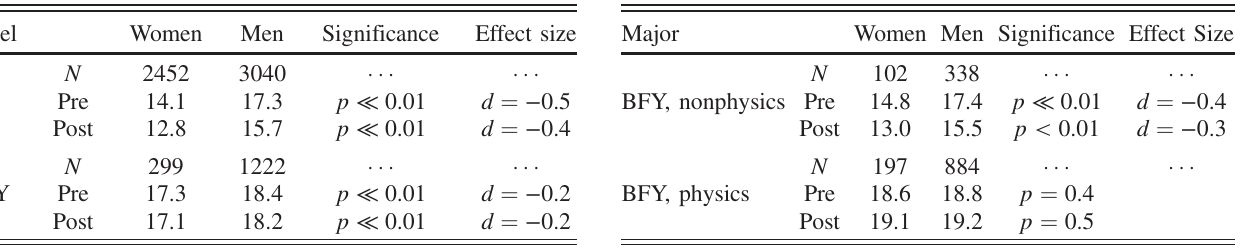
TABLE VI. Overall E-CLASS scores (points) for men and women on both the pre- and post-tests for the FY and BFY student populations separately. Significance indicates the statistical significance of the difference between women ’ s and men ’ s scores.